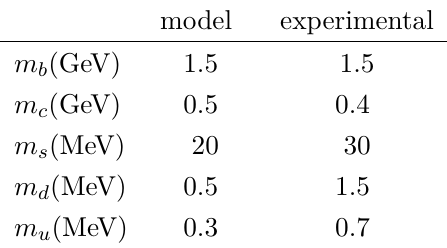
Table 2 . Quarks mass values obtained in the reference model (see text) and their experimental values evolved at the scale Λ = 10 8 GeV. A top mass value m t (Λ) = 102 . 5 GeV [57] has been used to fix the overall fermion mass